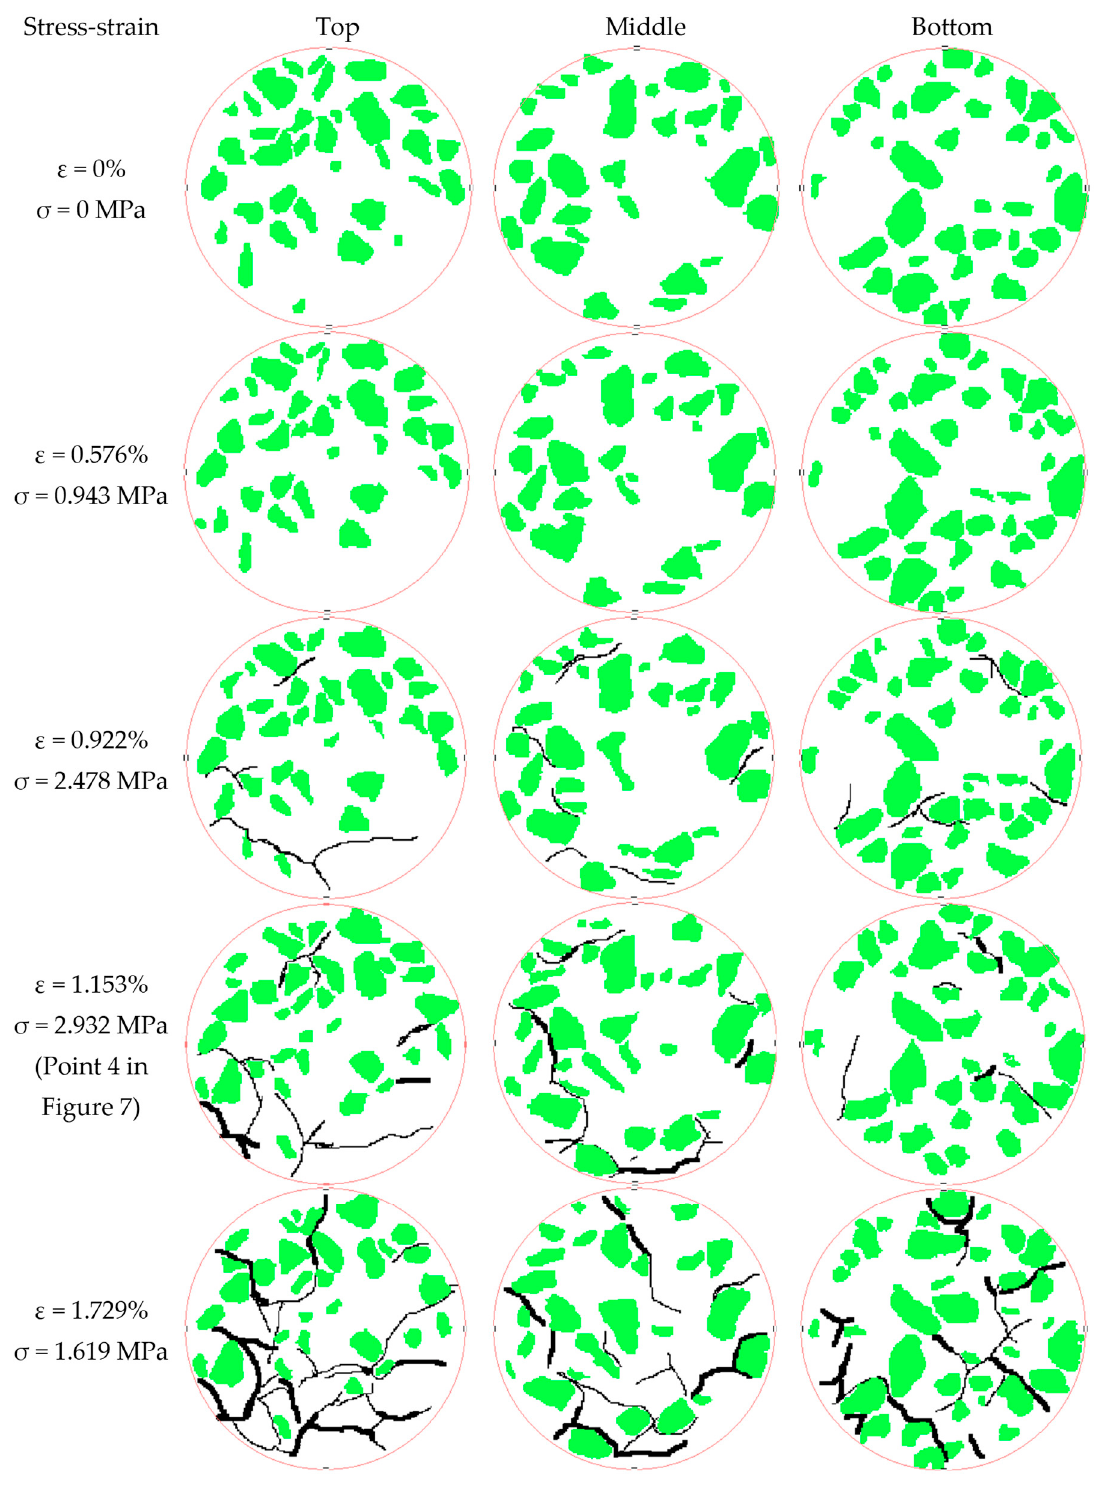
Figure 13. The extraction of waste rock and cracks on CT images under different deformation stages.